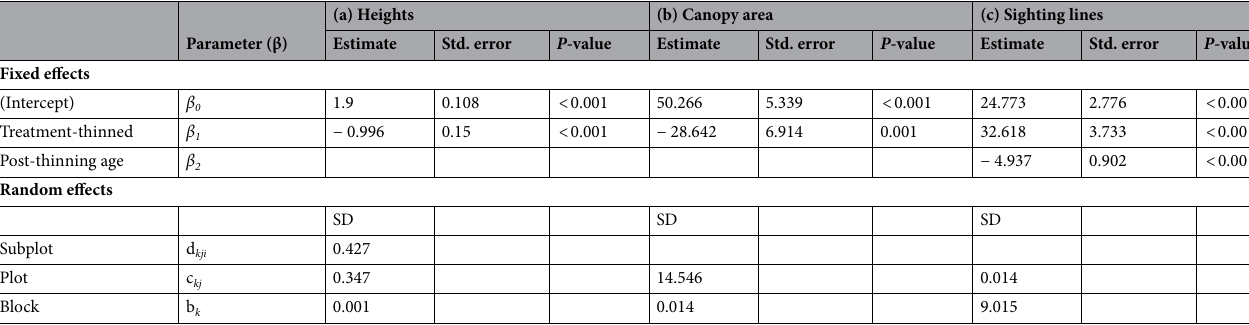
Table 9. Linear mixed effects (LME) models showing the effects of fixed factors (treatment, post-thinning age) on the vegetation structure (height, canopy area) of encroaching trees/shrubs, as well as on sighting lines in the thinned and non-thinned treatment areas.